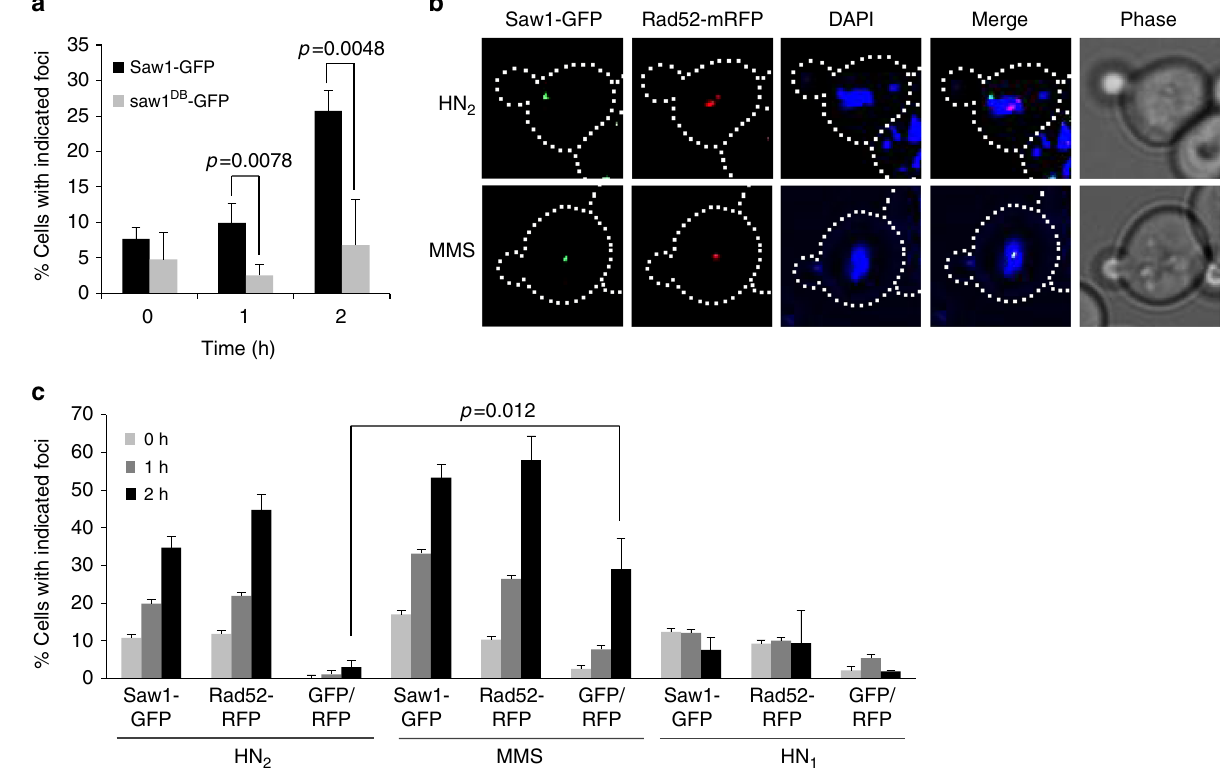
Fig. 2 HN 2 treatment induces Saw1-GFP foci. a HN 2 -induced Saw1-GFP and saw1 db- -GFP (DNA binding-de fi cient saw1 variant) foci formation. Saw1-GFP but not saw1 DB -GFP make nuclear foci upon HN 2 treatment (1 h, p value < 0.0078, 2 h, p value < 0.0048 using student t -test). b (Top) representative images of cells bearing HN 2 -induced Saw1-GFP and Rad52-mRFP. (Bottom) images of MMS-induced Saw1-GFP and Rad52-mRFP. DIC images are shown for cell shape. c Percentage of cells bearing Saw1-GFP or Rad52-mRFP upon indicated drug treatments. Shown are the average + s.d. of three independent experiments. At least 100 cells were counted per experiment. Saw1-GFP and Rad52-GFP co-localize upon MMS but not on HN 2 treatment ( p value < 0.012 using student t